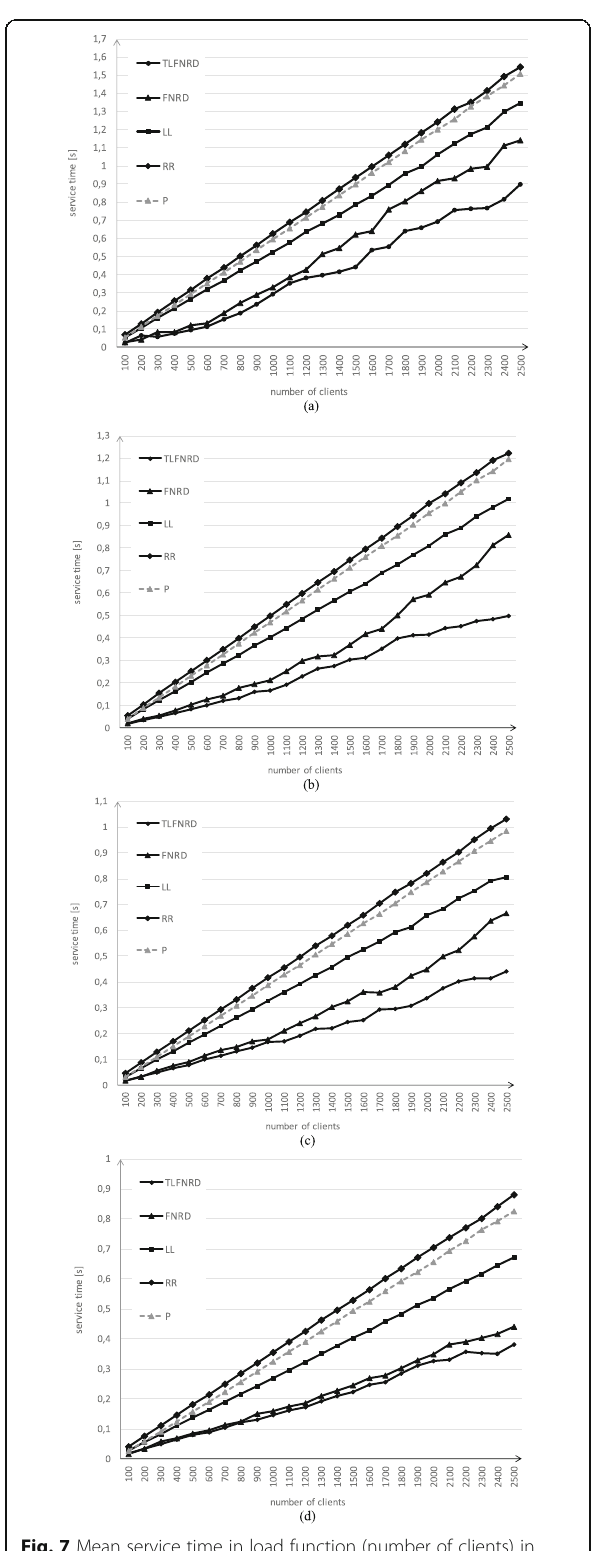
Fig. 7 Mean service time in load function (number of clients) in Web cluster containing: ( a ) 8 Web servers, ( b ) 10 Web servers, ( c ) 12 Web servers, ( d ) 14 Web